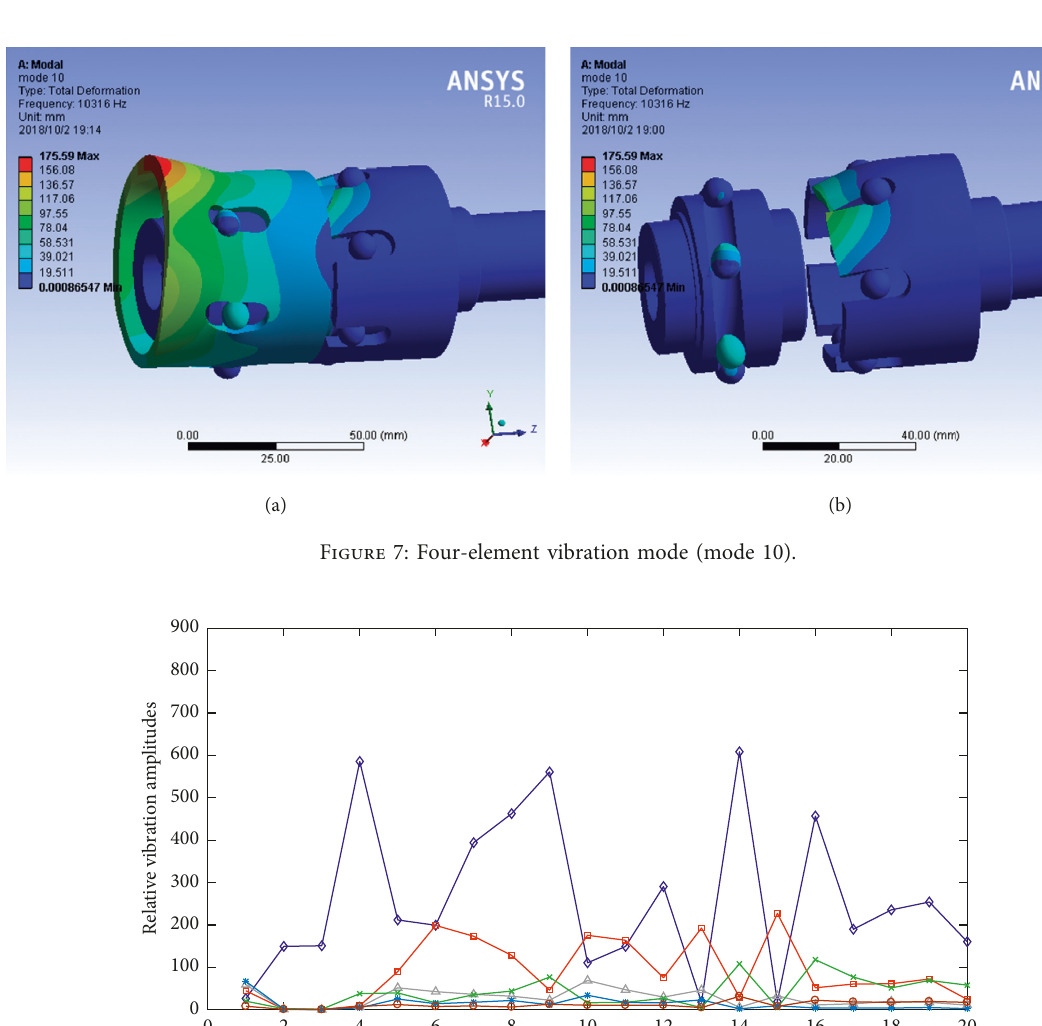
Figure 6: Three-element vibration mode (mode 17).